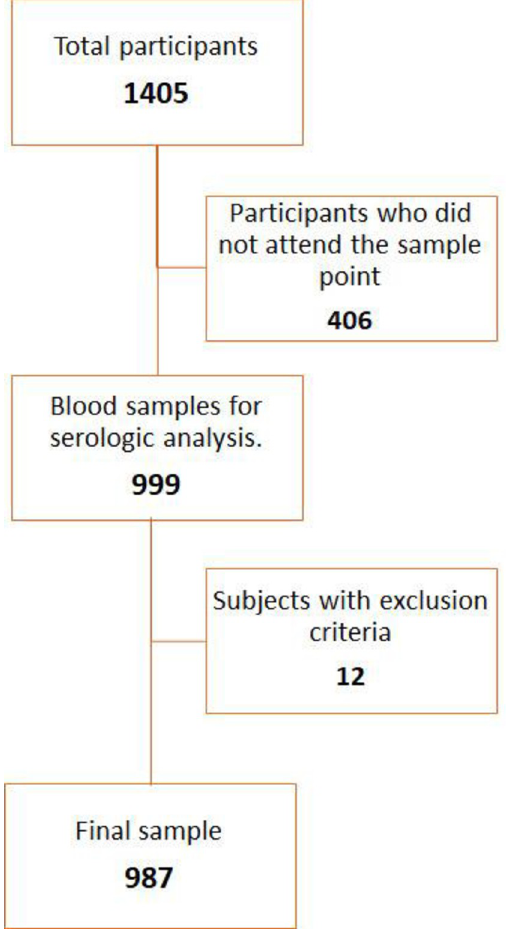
Fig 1. Flowchart of the participants who completed the survey and attended the sampling point to perform the serological test.